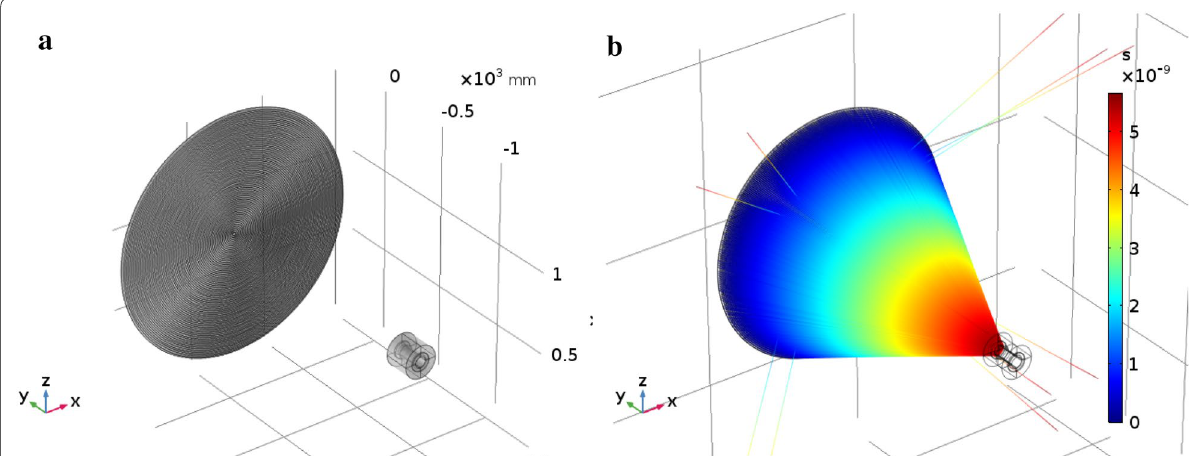
Fig. 11 Solar Stirling engine application ray tracing. a Fresnel concentrator setup in COMSOL ® . b Ray trajectories from ray-tracing simulation of 660 nm